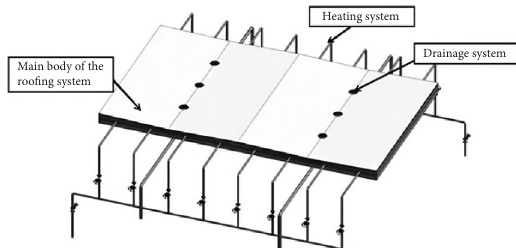
Figure 1: Overall diagram of the anti-leakage system of reinforced concrete flat roofs constructed in cold regions.